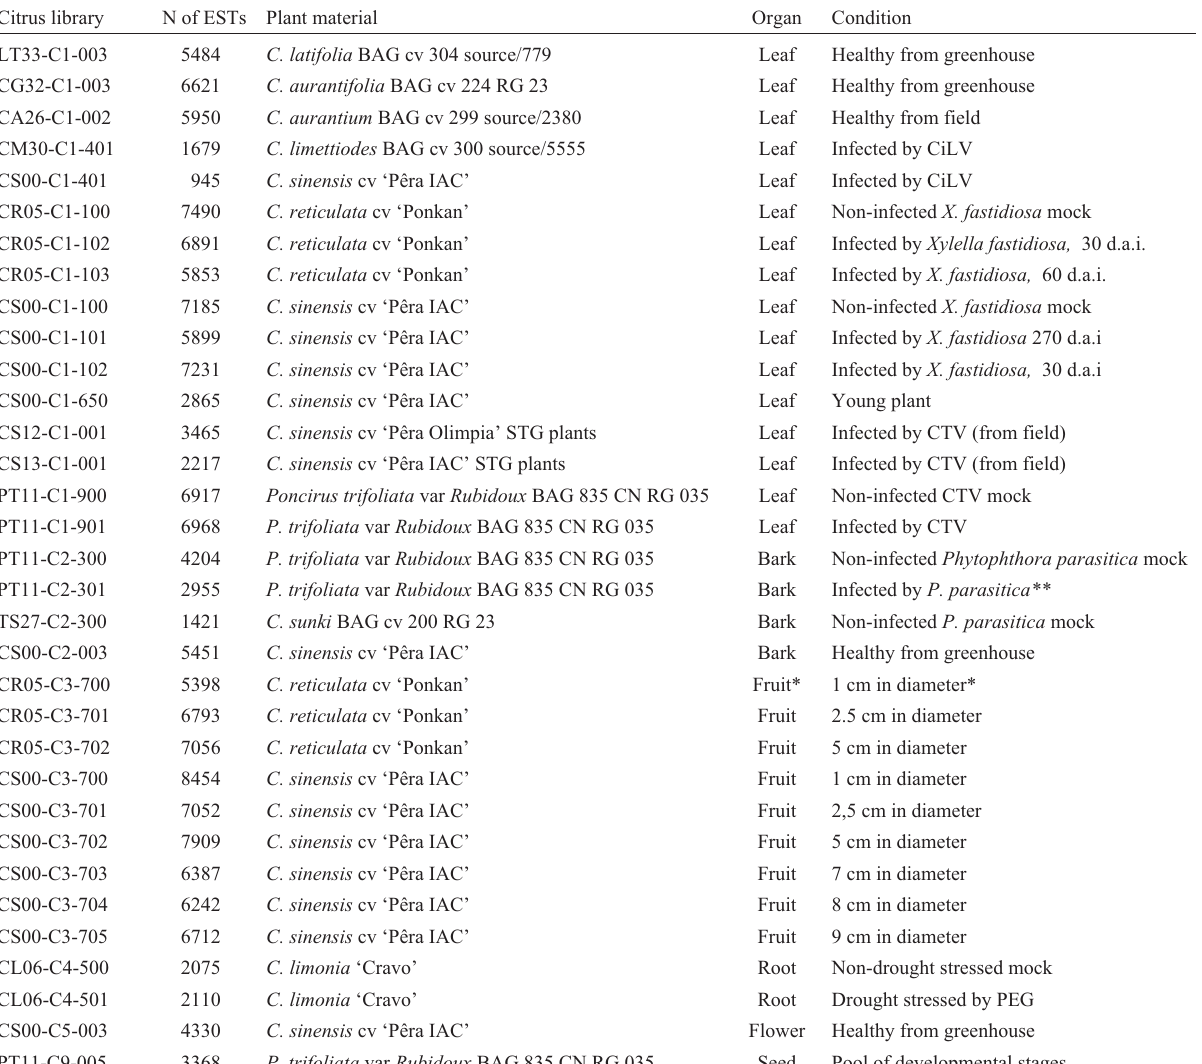
Table 2 - EST libraries used in this study. Citrus